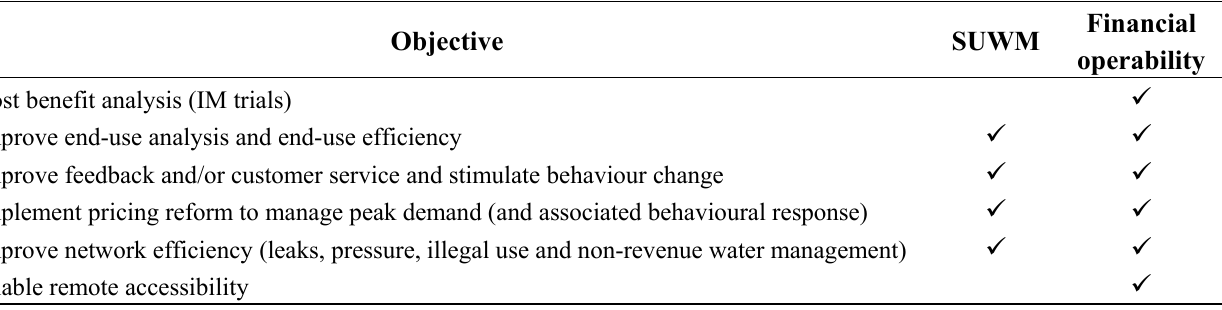
Table 3. Objectives of IM